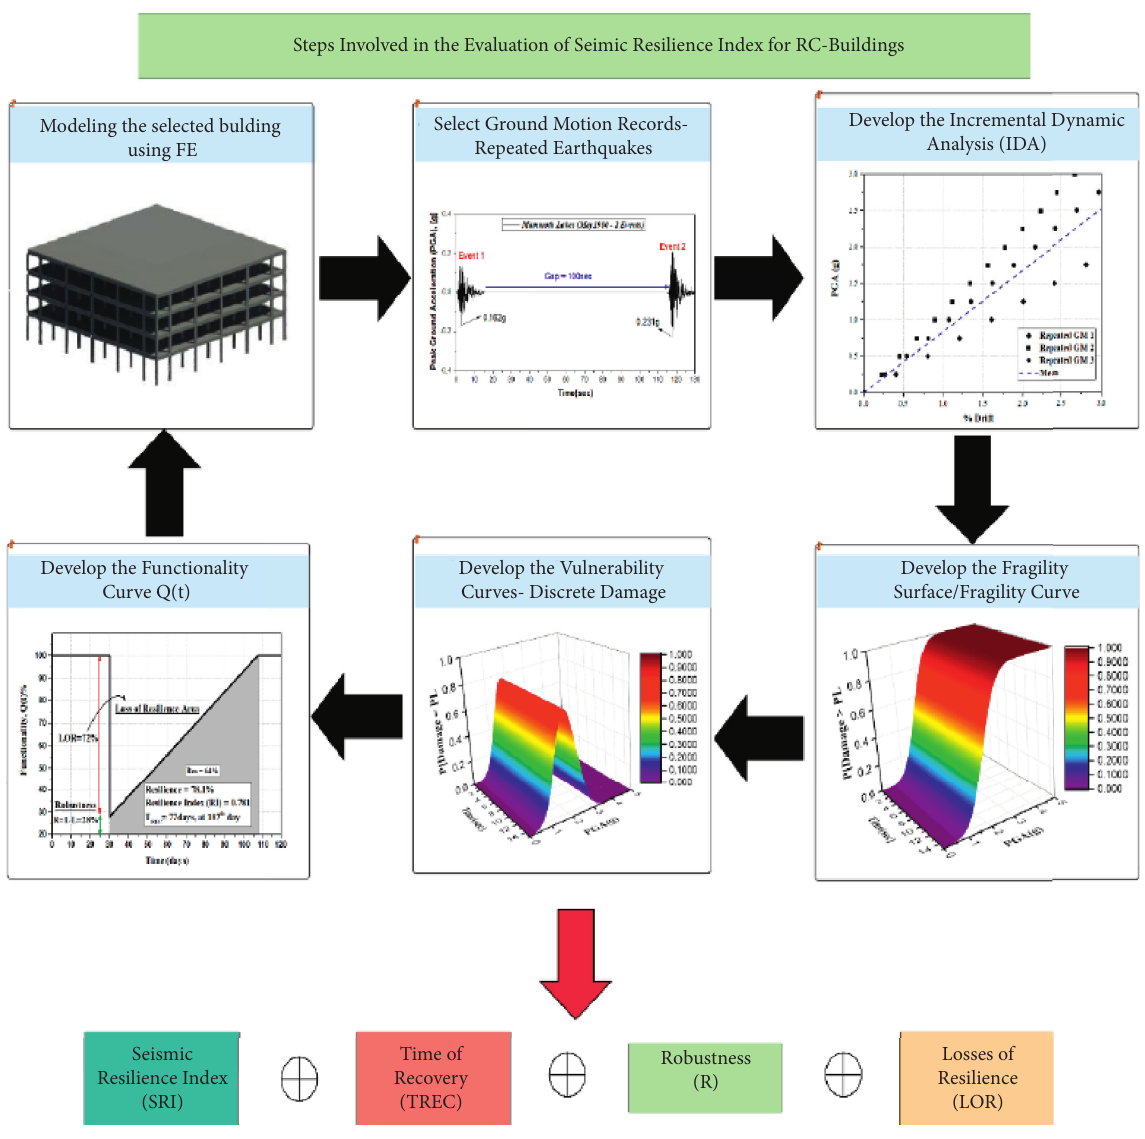
Figure 5: Framework steps for developing seismic resilience index (SRI) [50]. Table 4: Quantities or rates of depreciation for various types of buildings